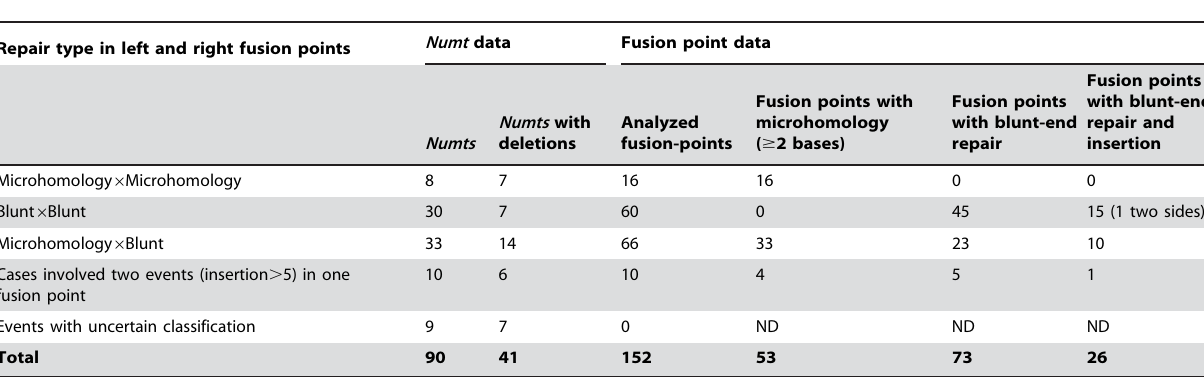
Table 1. 90 human and chimpanzee numts appear in this study and their classification to numt- chromosome fusion point. Numts are shown according to their two-side classification.